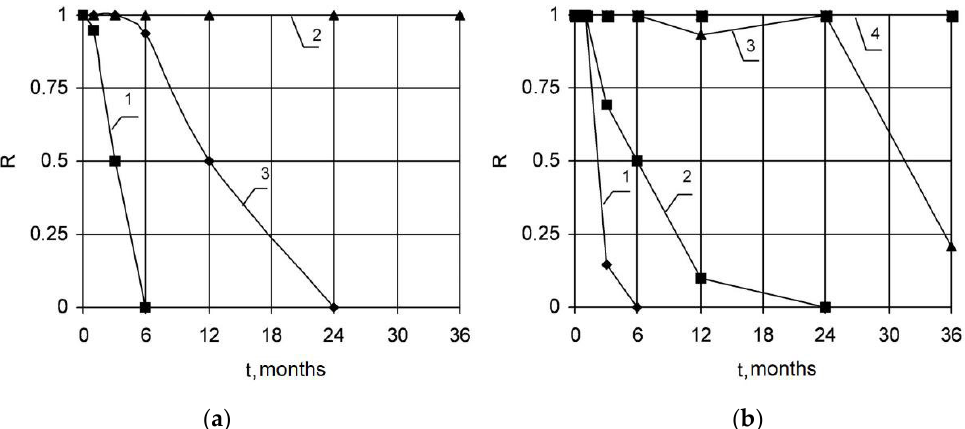
Figure 6. Dependence of the failure-free operation probability in cold climate conditions on the aging time of thermoplastics based on polypropylene: (1) MPP 15-04, colorless; (2) polycarbonate with short fiberglass; (3) BSPE 22007-16—( a ); for the samples made of thermoplastic BSPE 22007-16 with the following cross-sectional areas: (1) 1 × 2.5; (2) 2 × 5; (3) 3 × 13; (4) 8 × 25 mm—( b ). The graph shows that the failure-free operation probability for the considered model depends significantly on the aging time, especially in the case of poorly stabilized color- less thermoplastics. The probability of failure-free operation drops to 0.5 within 3 months for a block copolymer of propylene with ethylene, and within 12 months for frost-resistant polypropylene.